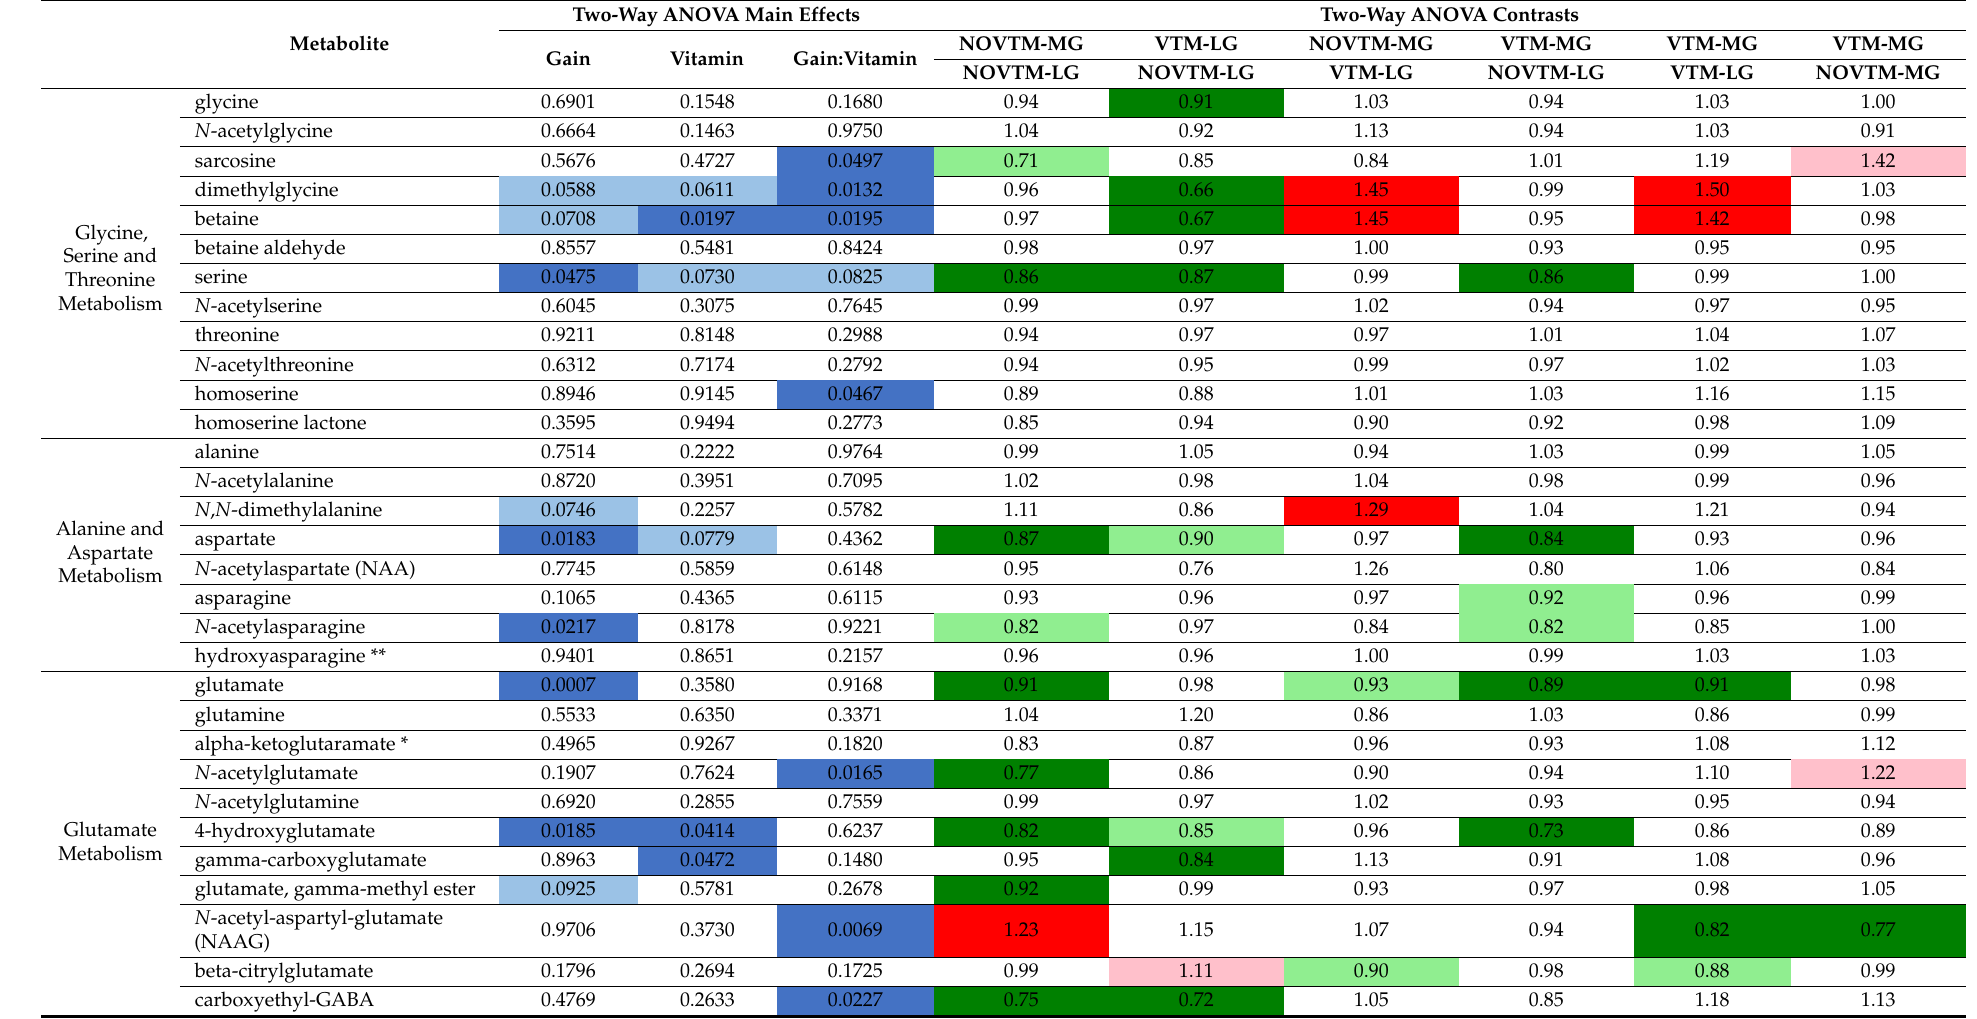
Table 2. Metabolites involved in amino acid metabolism pathways including: (1) Glycine, Serine, and Threonine, (2) Alanine and Aspartate, (3) Glutamine, (4) Histidine, and (5) Lysine